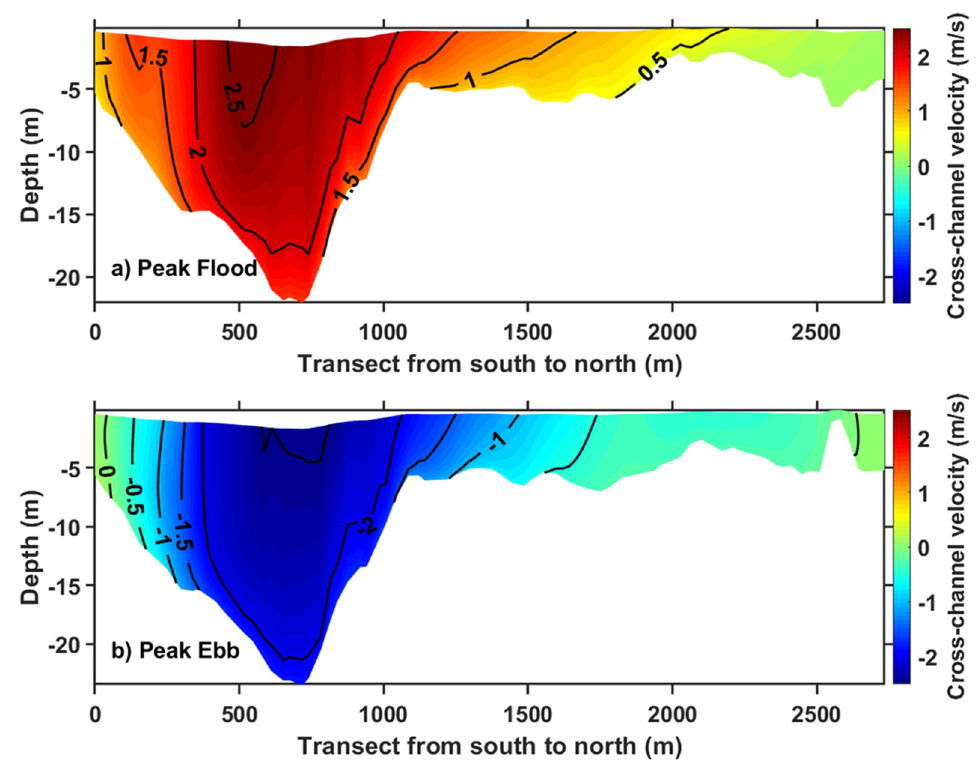
Figure 11. Normal velocity magnitudes at ( a ) peak flood and ( b ) peak ebb tides along cross section XS3 in Cobscook Bay. Positive velocity is away from the reader. The cross-section location is shown in Figure 1.